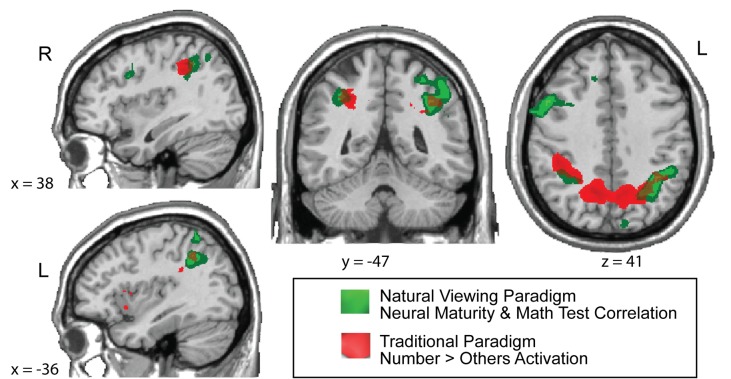
Illustration of overlap in IPS activation between the math-related activation from the natural viewing task (from
Figure 2A
) and the number-related activation from the traditional task (from
Figure 7B
).The statistical thresholds and parameter ranges are the same as in the original figures: Figures 2A and 7B.